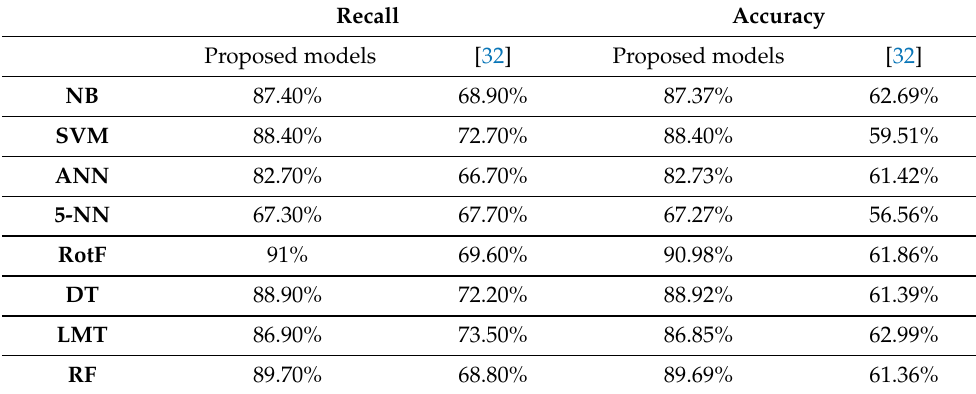
Table 5. Performance Comparison of ML